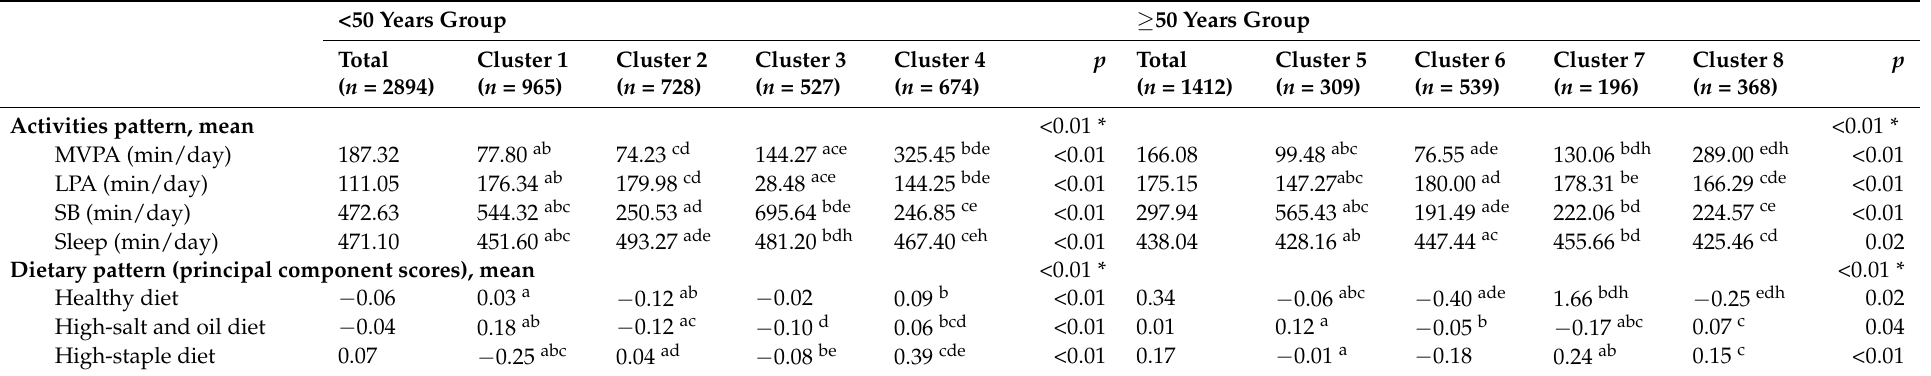
Table 2. Activities and dietary characteristics of lifestyle behavior